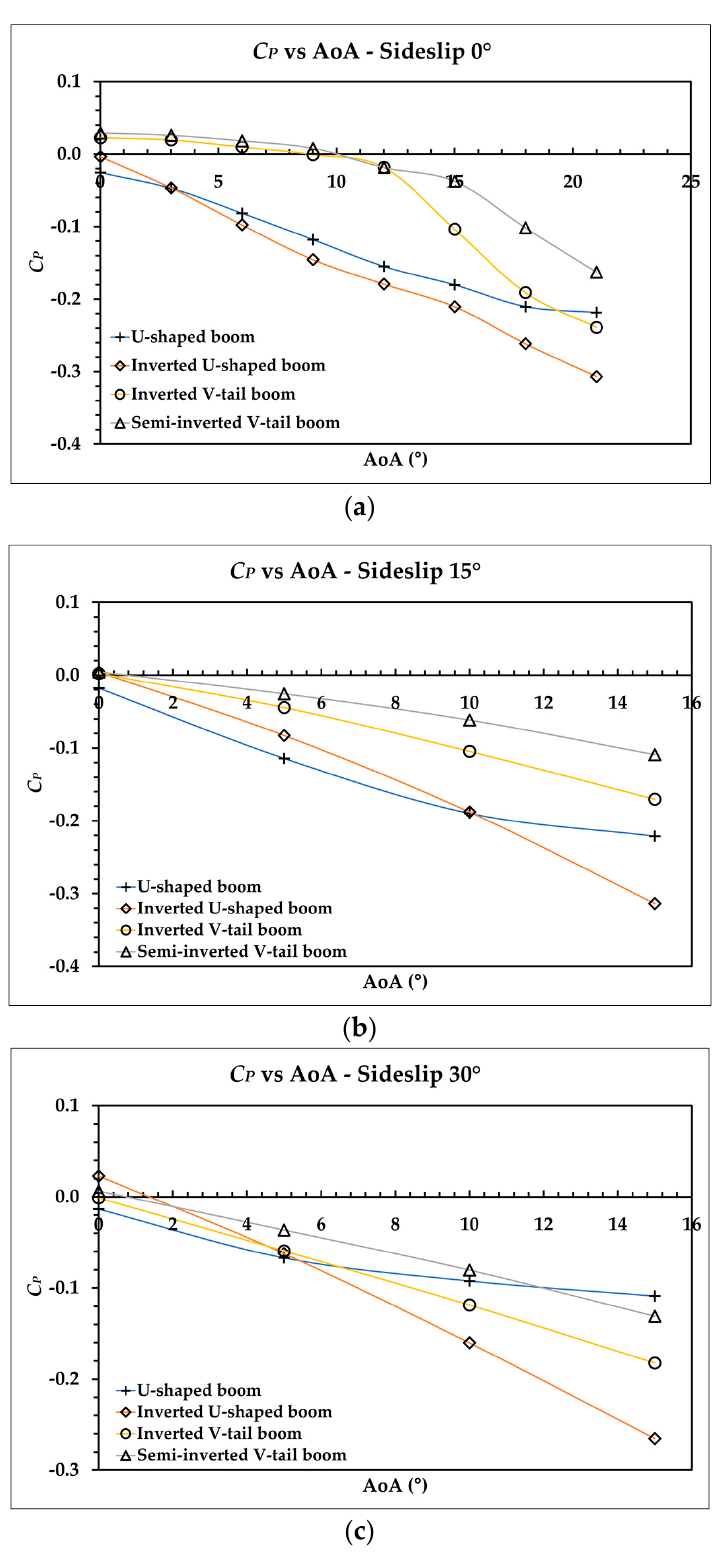
Figure 14. Pressure contour on 15° AoA, sideslip angle: ( a ) 15° and ( b ) 30°. The C P value was analyzed to find the longitudinal stability of the aircraft. The mo- ment aerodynamics value on the CoG was used to find out the C P value using Equation (25). Figure 15 shows a graph of the coefficient of moment vs. AoA during crosswind.